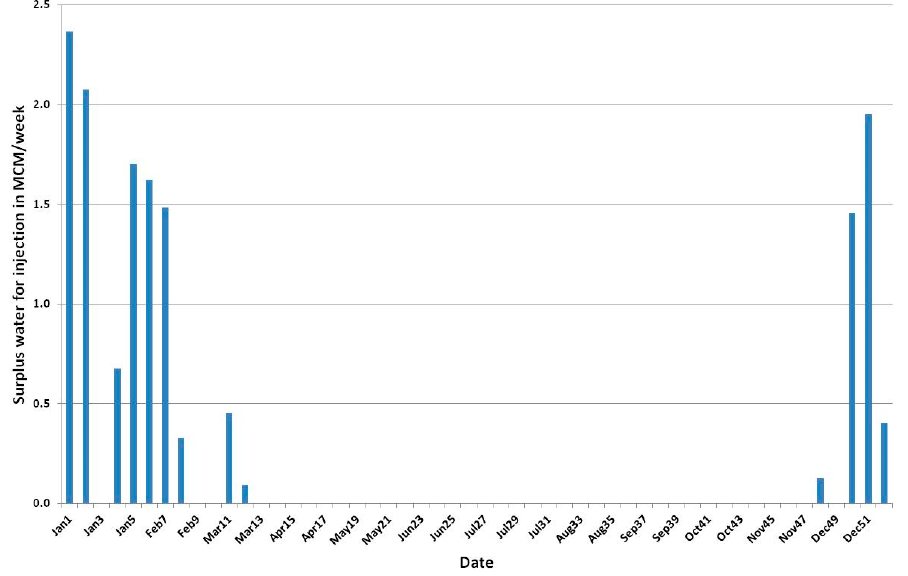
Figure 1. Typical weekly surplus water in the Israel National Water system in an average